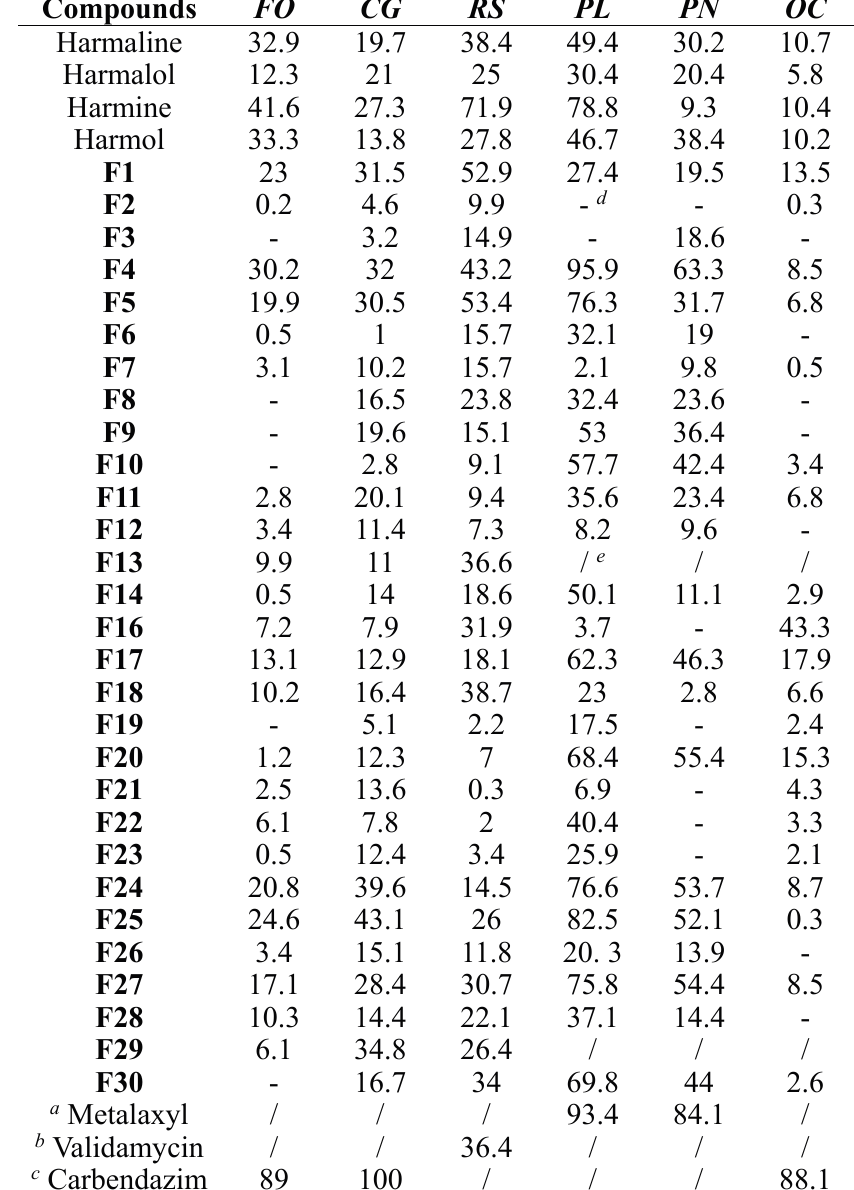
Table 1. Fungicidal activities of harmine, harmane, harmaline, harmalol, and compounds F1 – 30 against six kinds of fungi (percent inhibition, %; 100